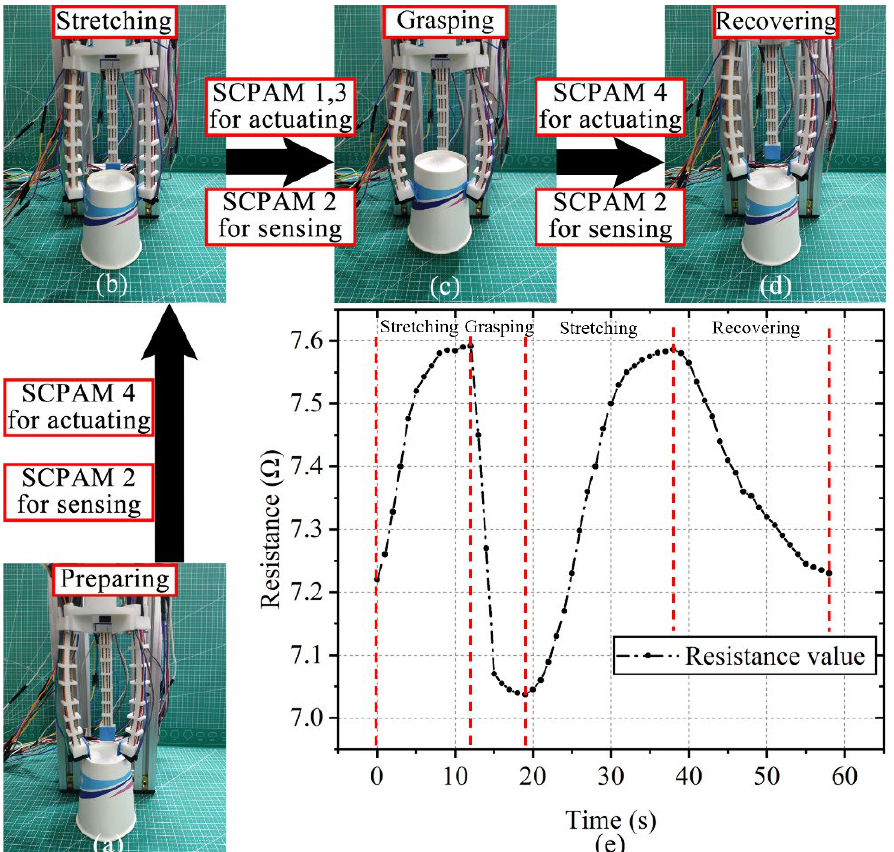
Figure 11. Actuation–sensing integration test of the gripper and resistance change of the sensor dur- ing the test. ( a – d ) The four stages of the gripper include the preparation stage, the stretching stage, the grasping stage, and the recovering stage, respectively. ( e ) The changes in the resistance value of the sensor during the test.